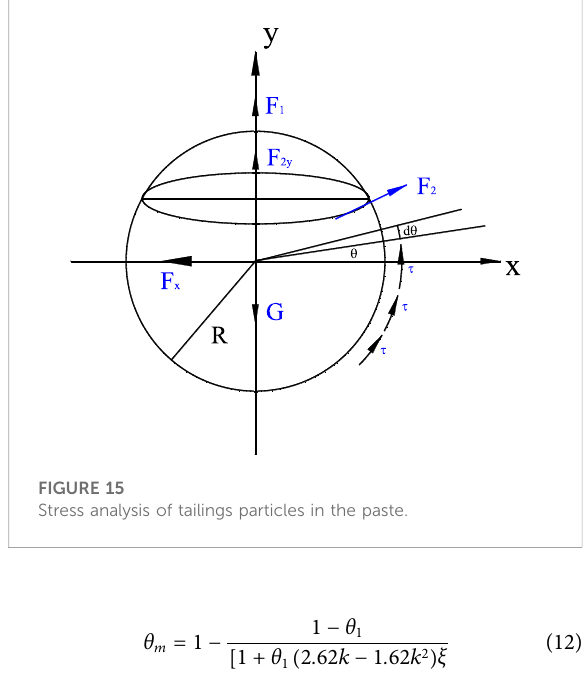
FIGURE 15 Stress analysis of tailings particles in the